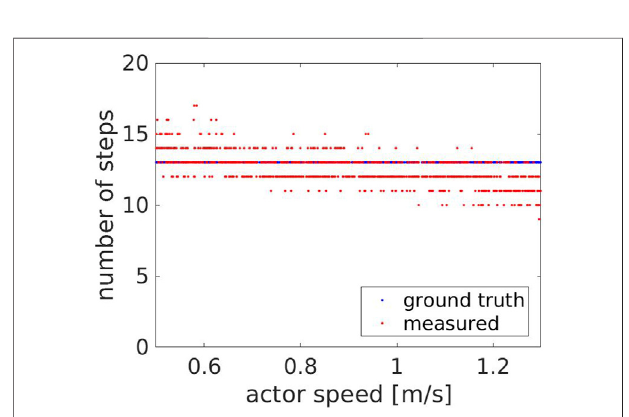
FIGURE 6 | Experiment 1: the measured (red) and the ground truth number of steps (blue) with respect to the Actor ’ s speed.